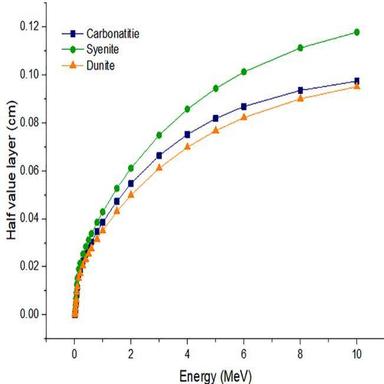
Variation of half value layers as a function of photon energy (MeV).